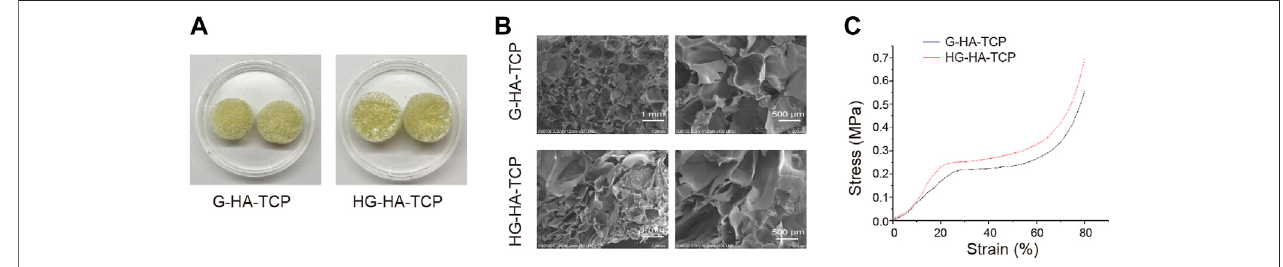
FIGURE 2 | Characteristics of scaffolds. (A) Surface morphology of scaffolds. (B) Internal structure of scaffolds as observed usingSEM. (C) Stress-strain curve of